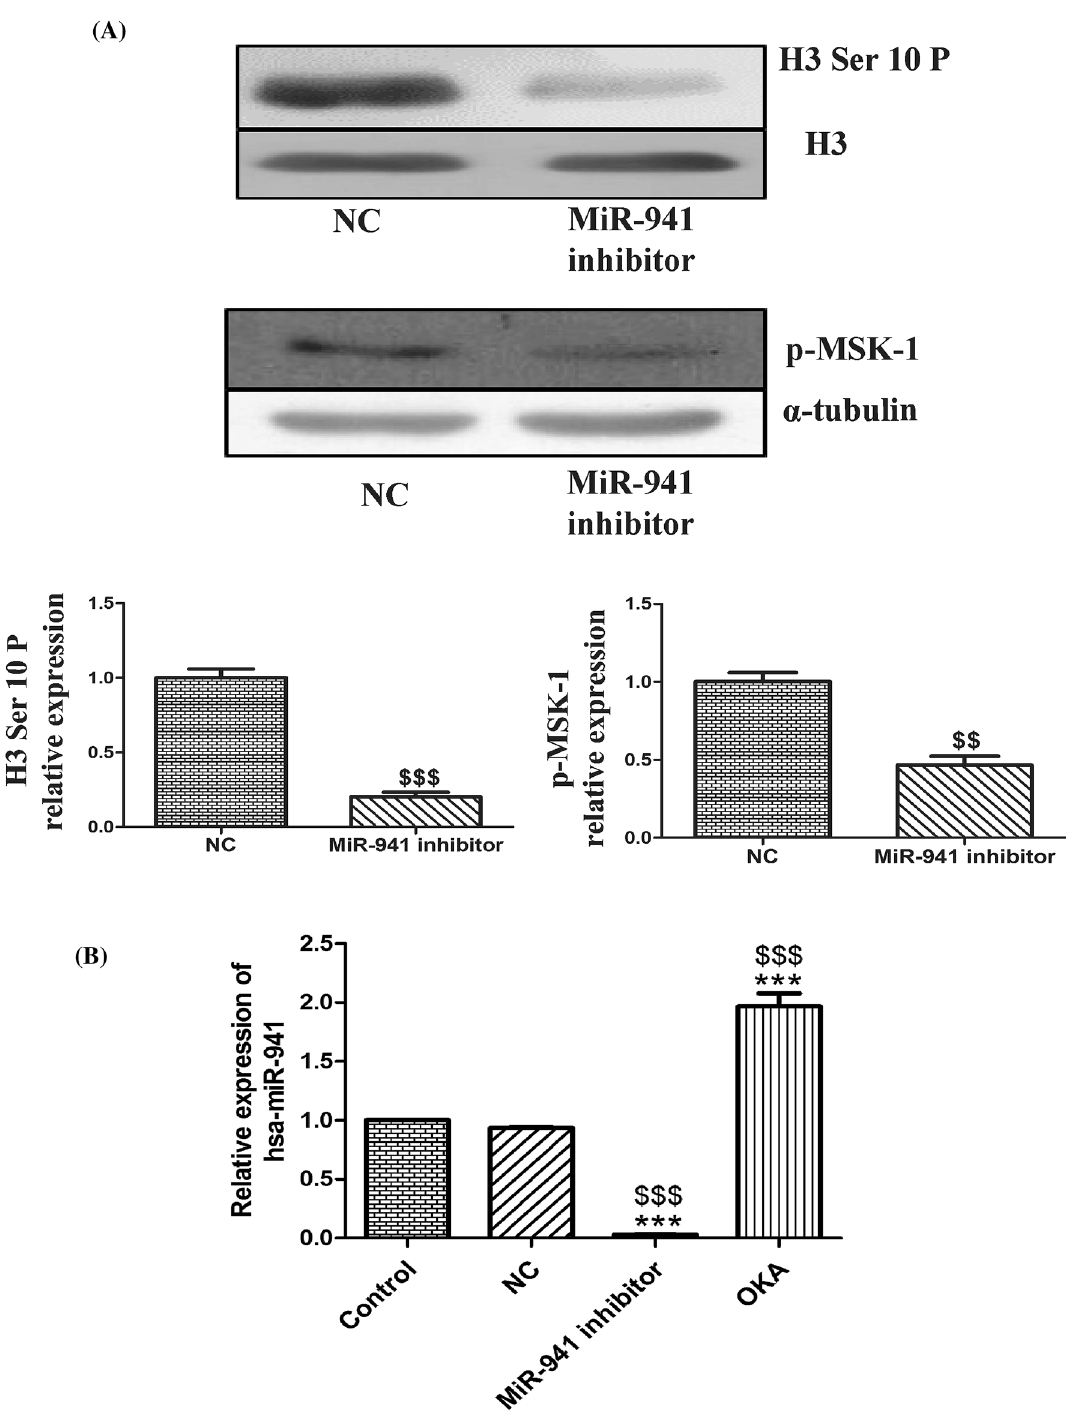
Figure 4. Epigenetic alterations of microRNA-941 inhibitor in MDA-MB-231 cells. ( A ) Western blots and densitometric analysis of p-H3 (Ser 10) and p-MSK-1 in MiR-941 inhibitor transfected MDA-MB-231 cells for 24 h. ( B ) Quantitative real-time PCR based relative expression of hsa-miR-941 in MDA-MB-231 control, negative control, and miRNA-941 inhibitor and okadaic acid (5 nM) treatment group. α-Tubulin and H3 were used as loading controls for our experiment. Three independent experiments were performed for each cell type. All values were expressed as mean ± S.E.M. ***p < 0.001 significant vs untreated MDA-MB-231 cells (control group). $$ p < 0.01, $$$ p < 0.001 significant vs Negative control